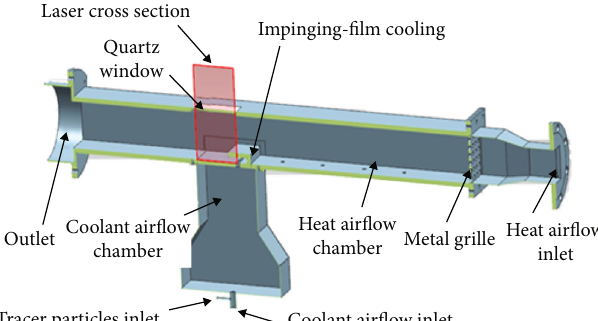
Figure 5: Details of the test section.